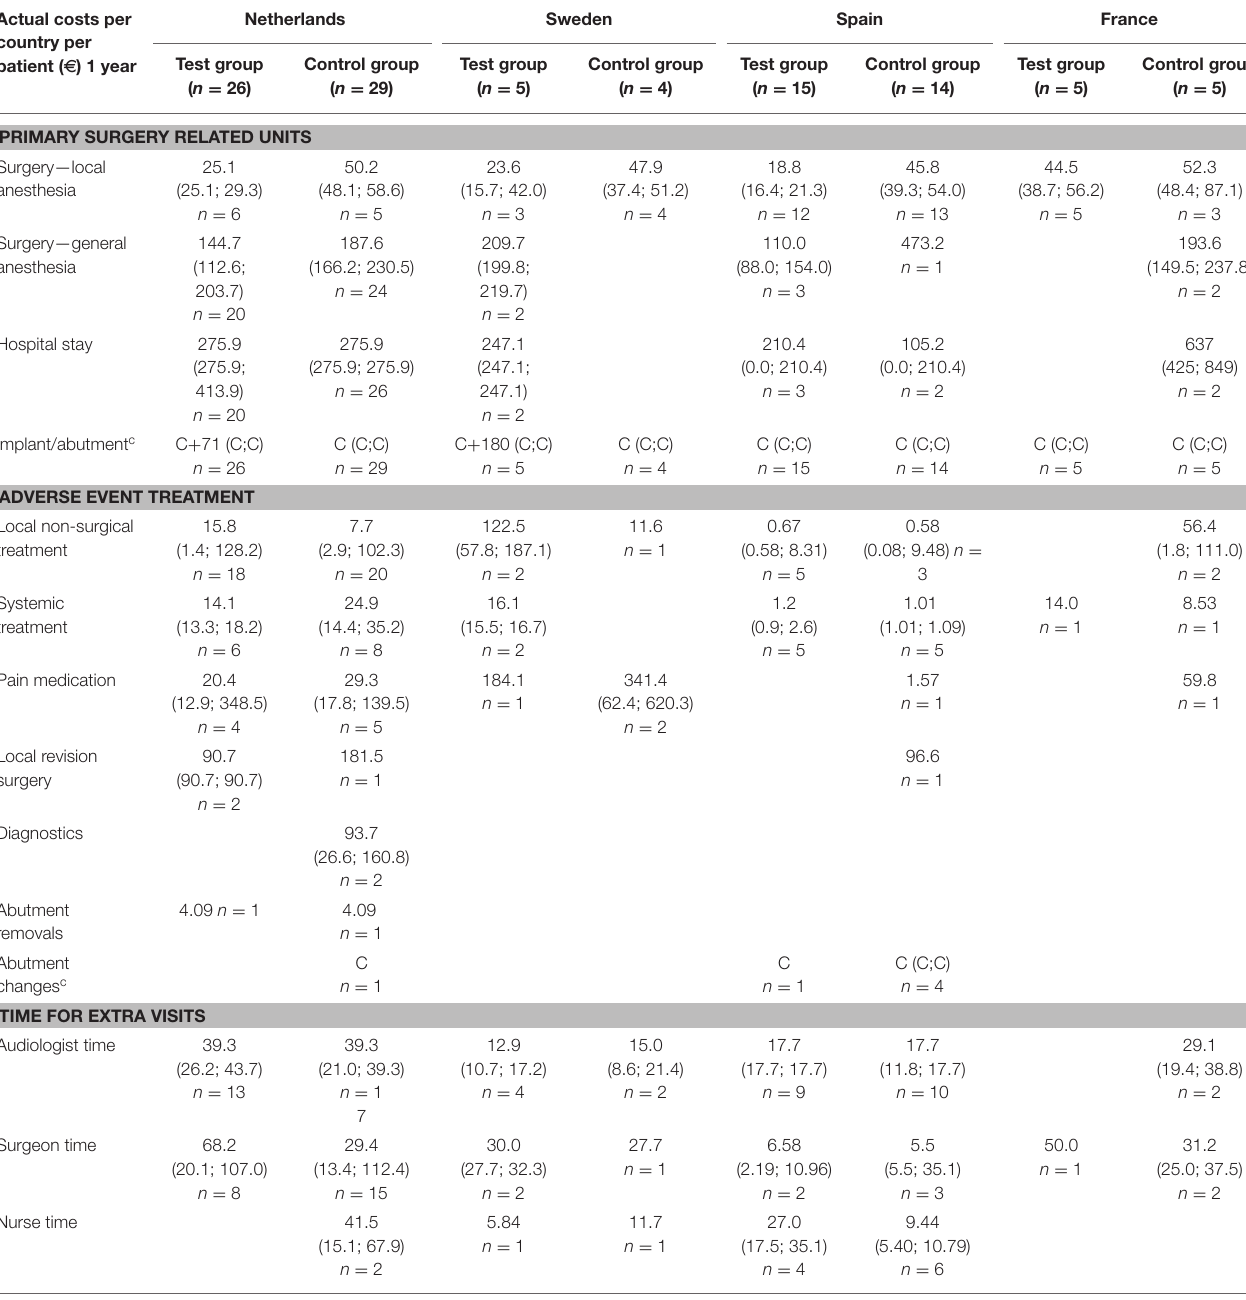
TABLE 4A | Costs per country after 1